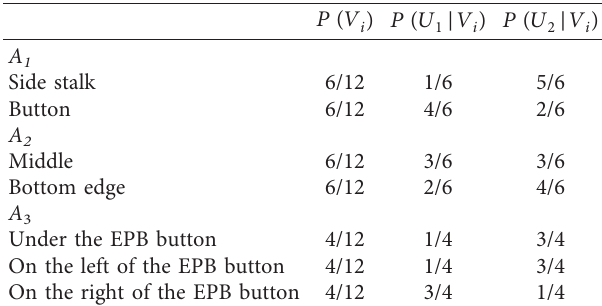
Table 3: The probabilities of the three factors and each